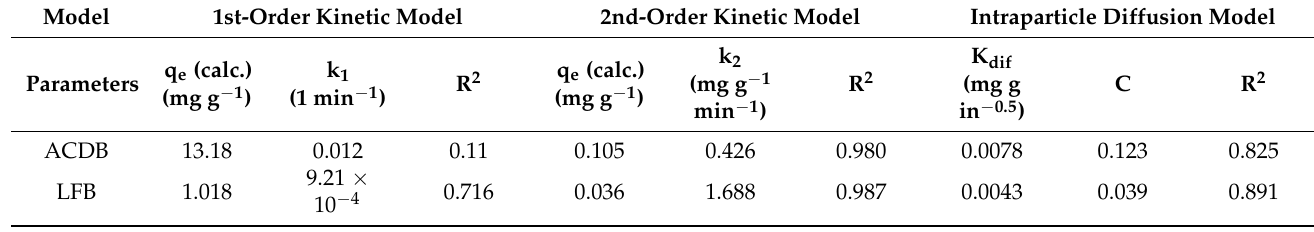
Table 4. Comparison of the kinetic model for IV2R dyes from ACDB and LFB.